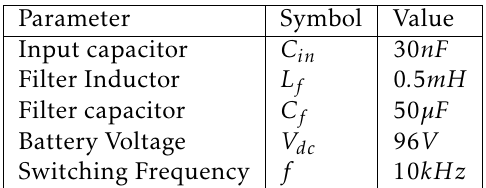
Table 2. Reference for parameters used throughout